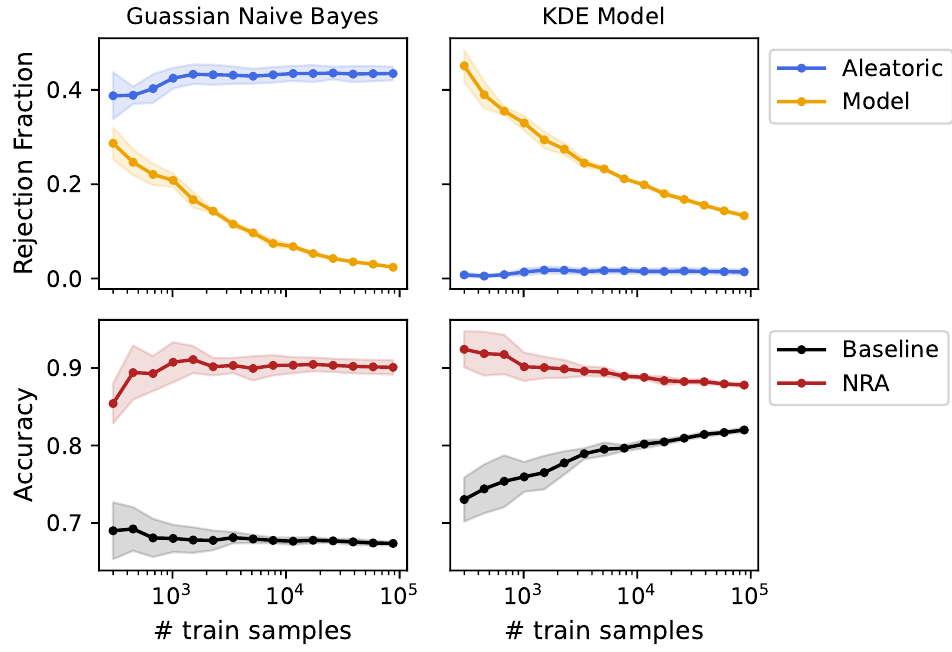
Figure 5. Uncertainties’ rejection fraction and obtained accuracies using a k-fold cross-validation with an increasing number of training samples for Gaussian NB and KDE Bayes models.